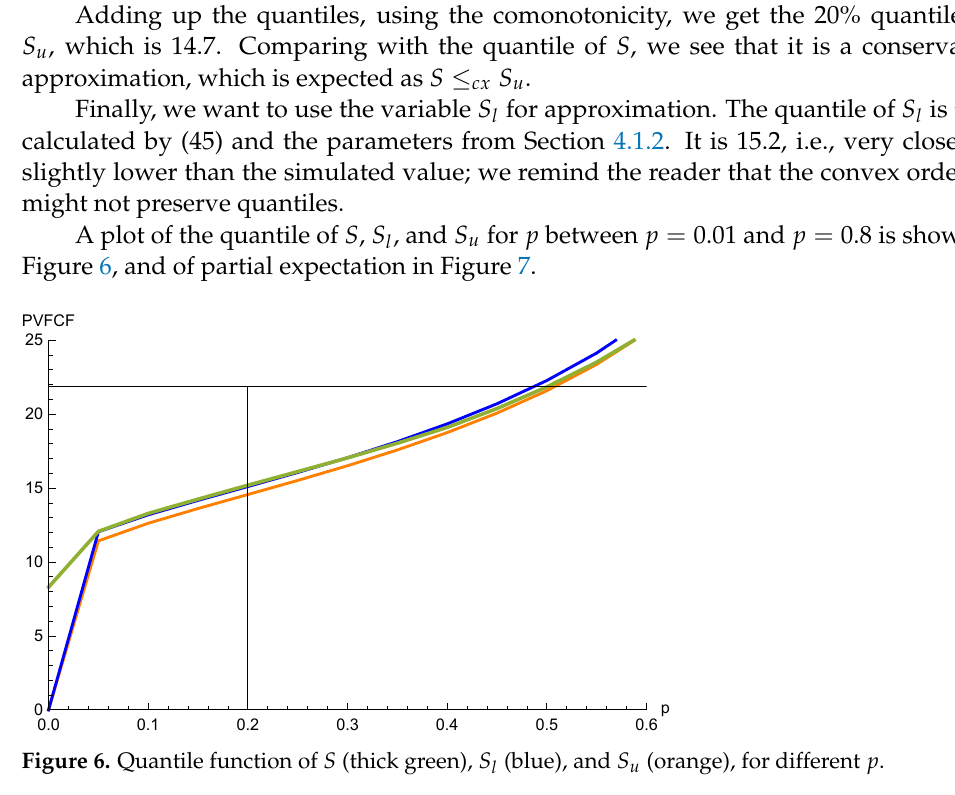
Figure 5. 20% (blue) and 80% (orange) quantile of the cash flow in each time point t .